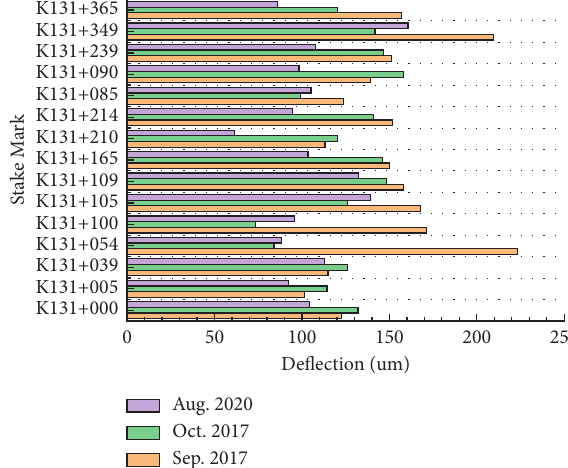
Figure 17: Comparison of average deflections measured in three tests with a 5T